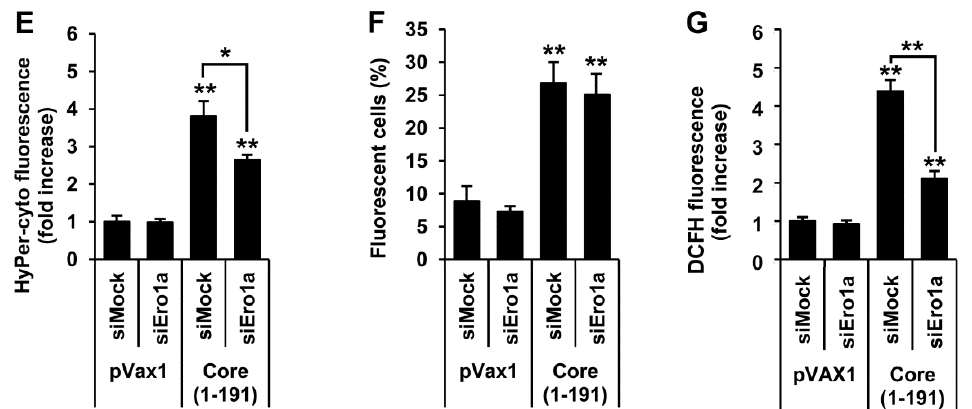
Figure 5. Fragment encompassing aa 37–191 of HCV core is responsible for the activation of ER oxidoreductin 1α (Ero1α) which contributes to the production of hydrogen peroxide. ( A , B ) Induction of the expression of Ero1α assessed by RT-qPCR ( A ) and Western-blotting ( B ) of Huh7 cells 40 h post transfection with plasmids expressing HCV core; ( C , D ) Silencing of Ero1α expression in naïve and HCV core-expressing Huh7 cells. Respective cells were